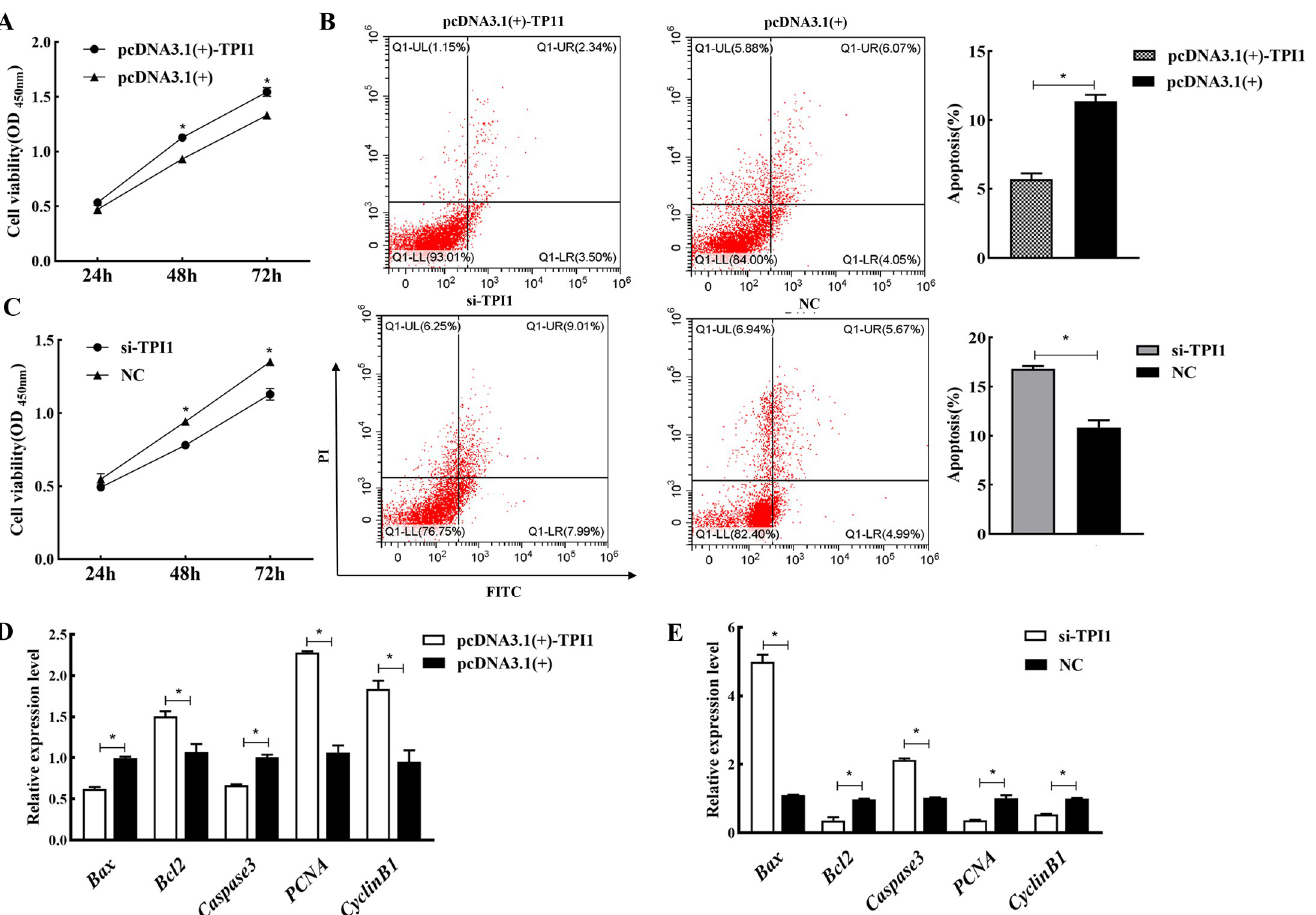
Fig 4. Effect of TP1 gene silencing and overexpression on the proliferation, cycle and apoptosis of SCs. A, C: CCK-8 detects the cell proliferation rate after overexpression and silencing of TPI1 ; B: Flow cytometry was used to detect the apoptosis of SCs after overexpression and silencing of TPI1 ; D, E: The effect of overexpression and silencing of TPI1 gene on the expression of proliferation, cycle and apoptosis related genes.